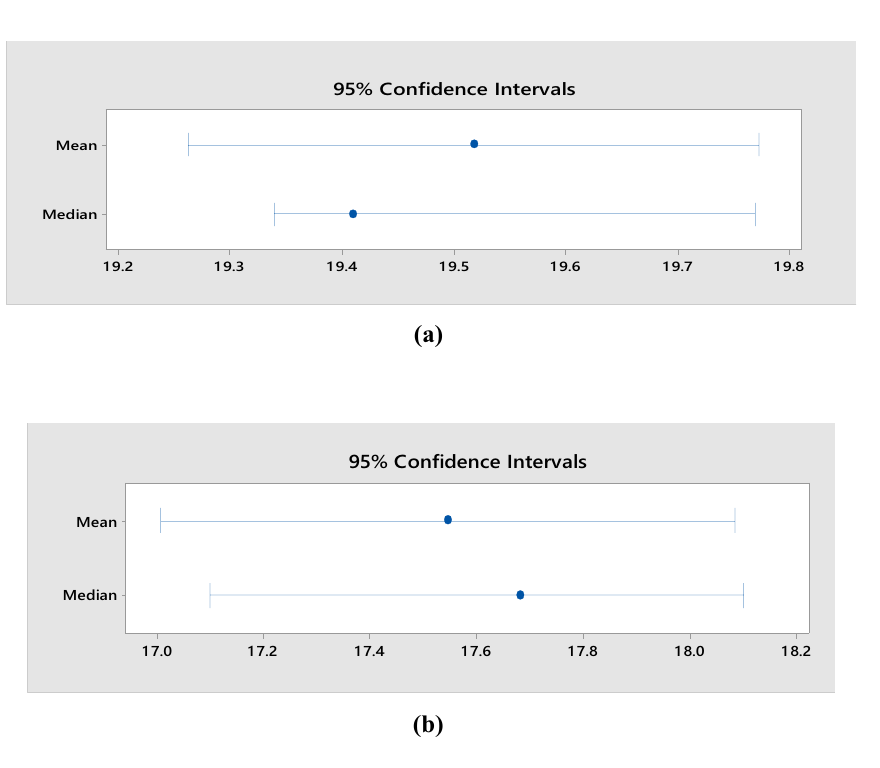
Figure 5. Mean, Median, and variability for compression tests on ( a ) Concrete ( b ) green